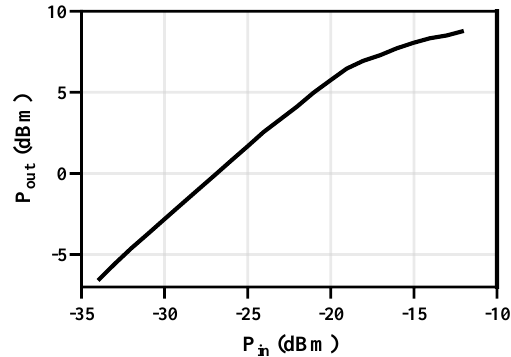
Figure 14. 1-dB compression point at 160 GHz.